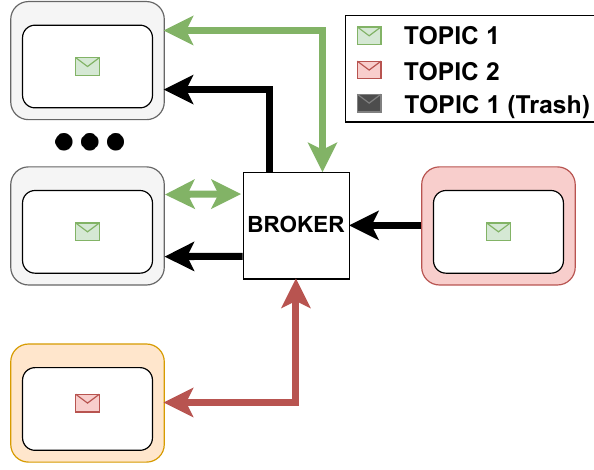
Figure 5. MQTT-SN trash injection